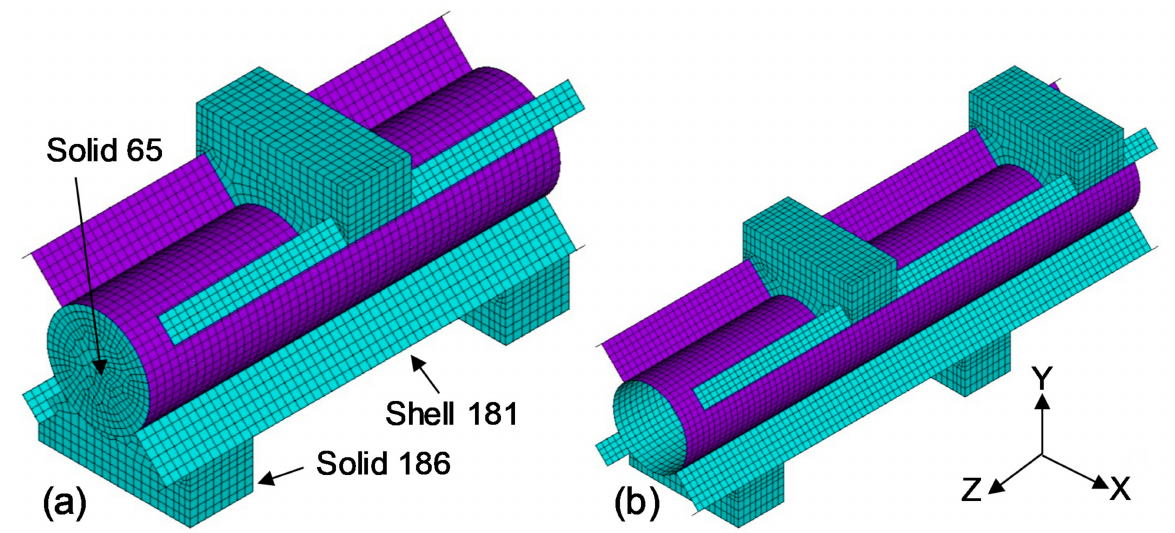
Figure 7. FE model, ( a ) SBS-1-NC and ( b )